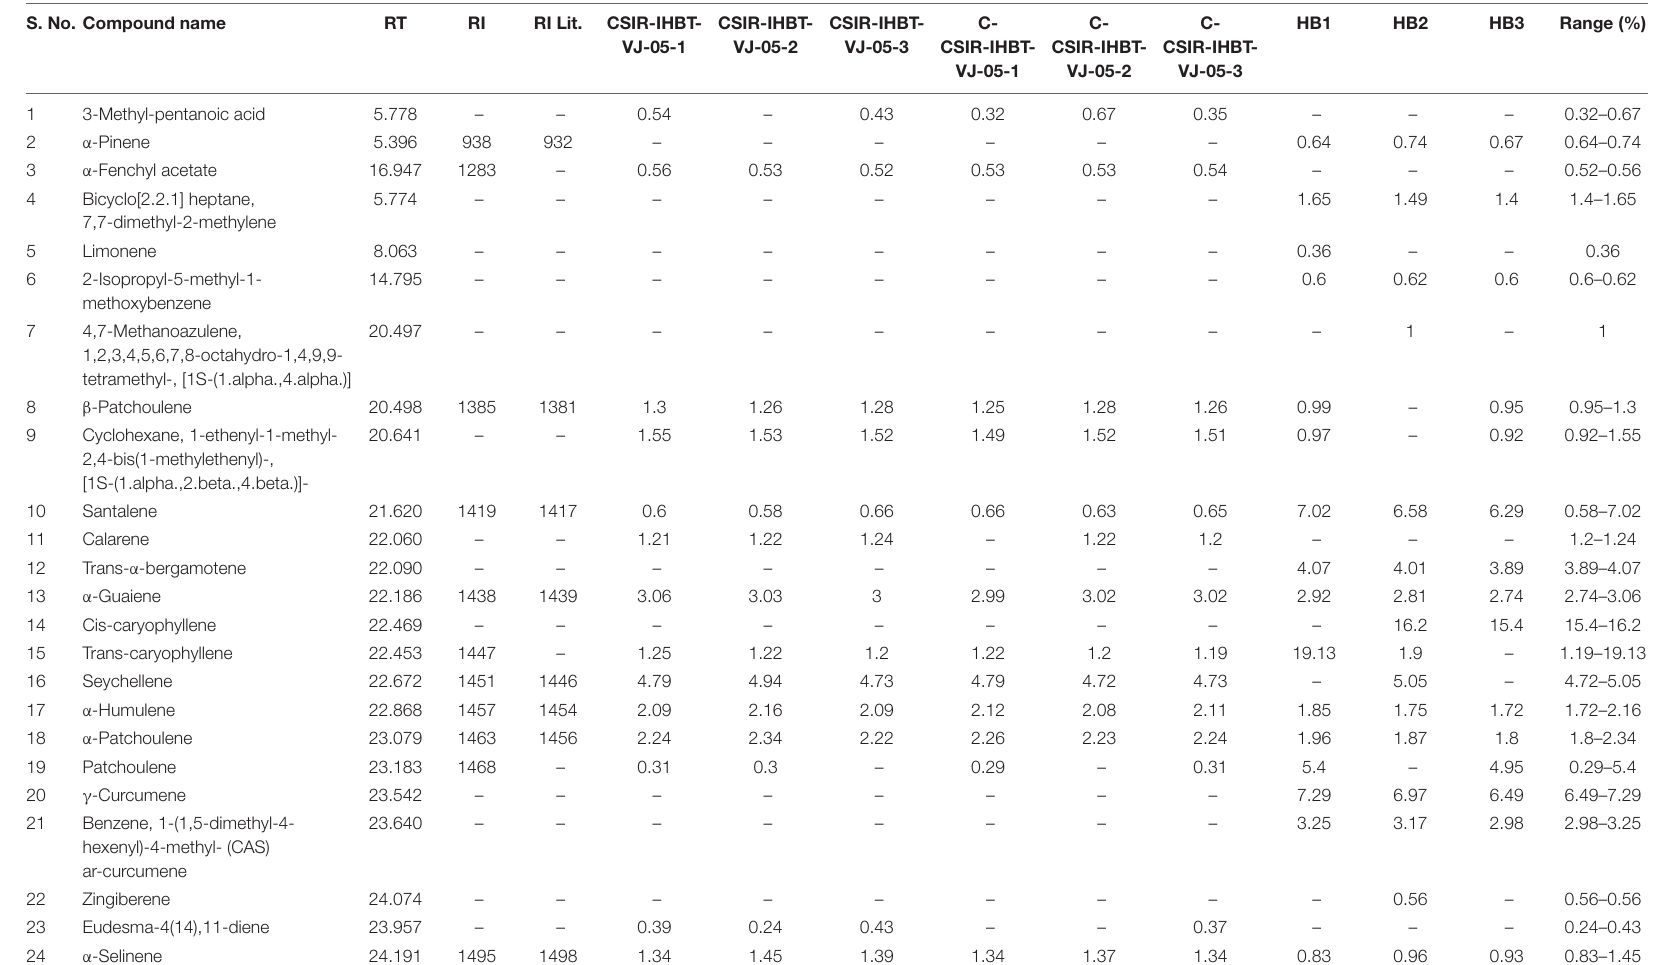
TABLE 4 | Essential oil composition of mother plants, clonally propagated plants of CSIR-IHBT-VJ-05, and seed raised plants of Himbala. S. No. Compound